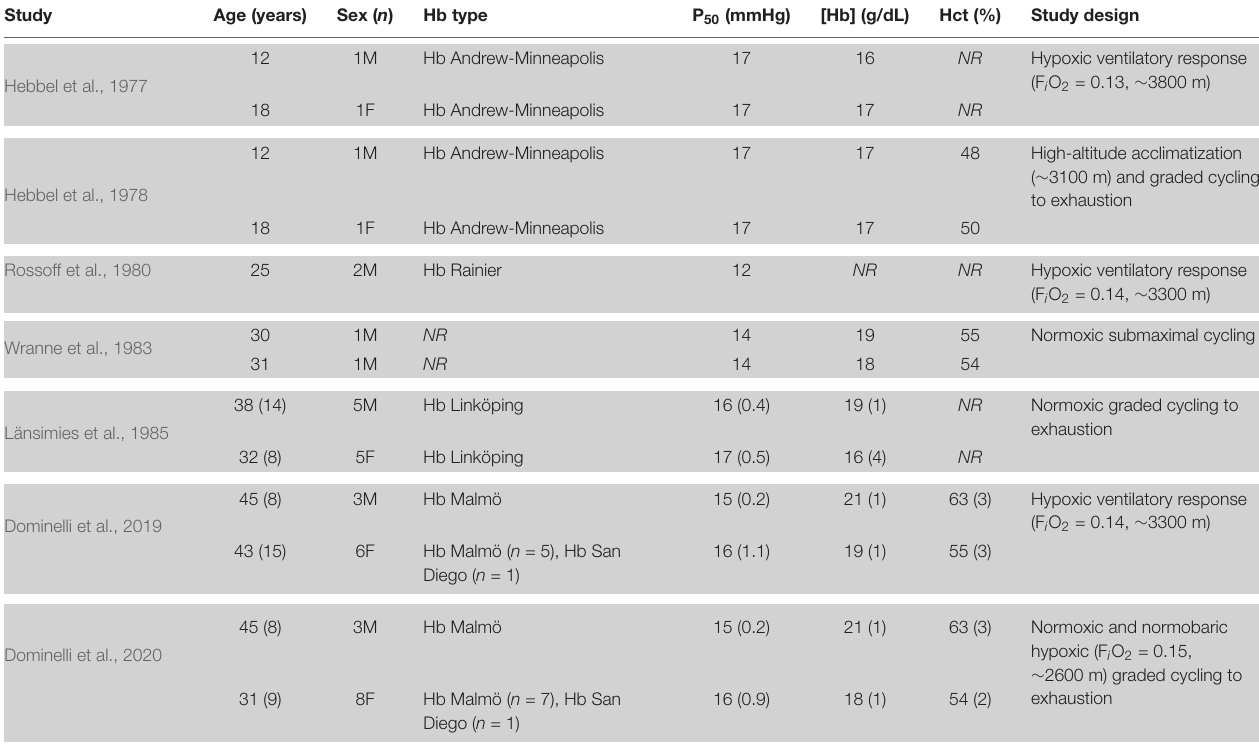
TABLE 1 | Studies examining cardiorespiratory adjustments during normoxia or hypoxia in humans with high Hb-O 2 affinity.